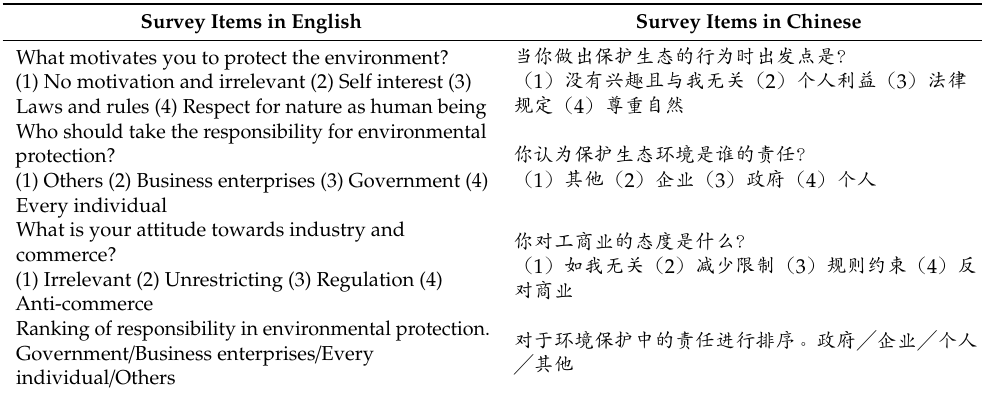
Table A2. Survey Items for Measuring